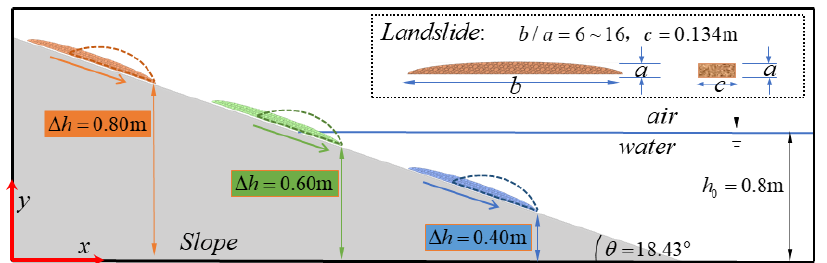
Figure 15. Setting diagram of cases of slider geometry under different submergence conditions.